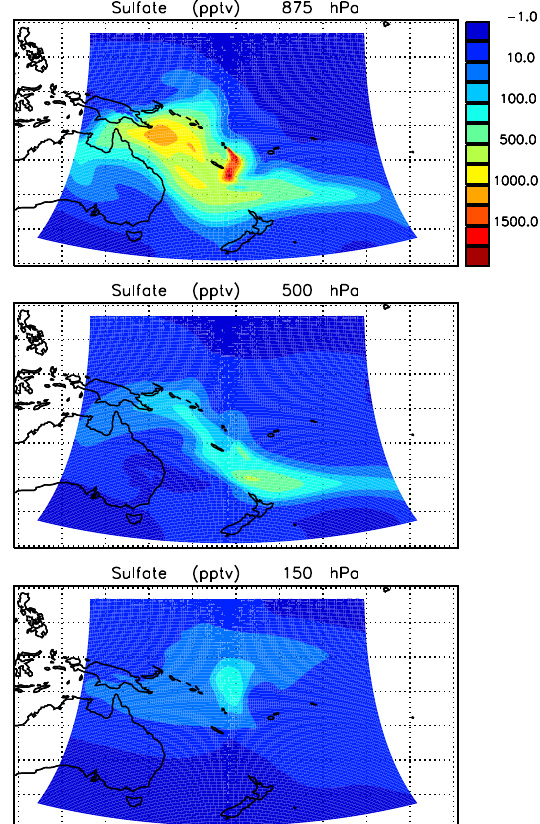
Figure 11. Daily mean difference (12 January 2005) between simu- lated sulfate in S1_HighT and in S0 at 875, 500 and 150hPa for the 50km × 50km grid.